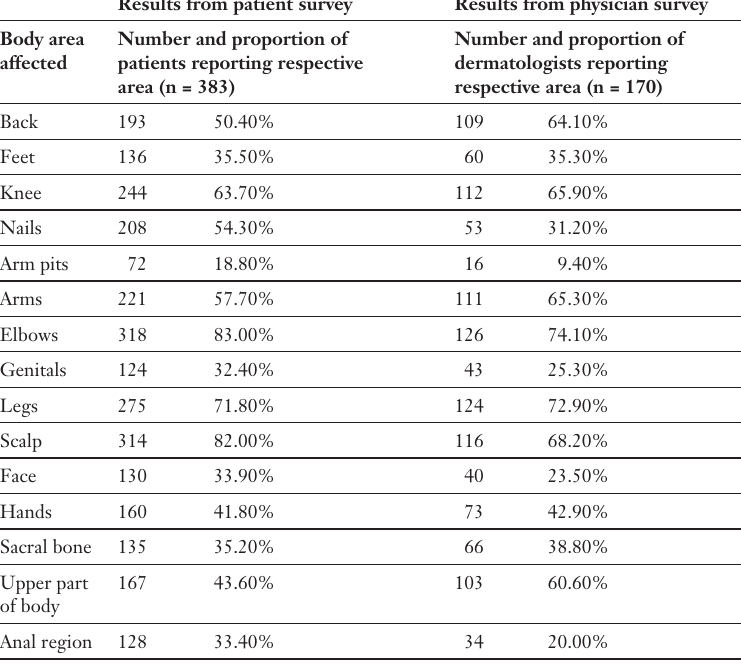
Body areas affected as reported from patient and physician survey (multiple answers were possible). Results from patient survey